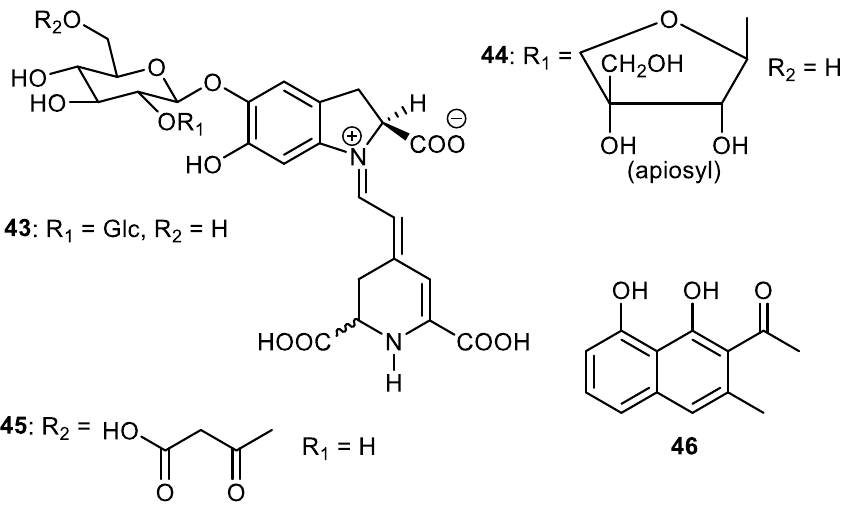
Figure 6. Structures of naphthalene and betacyanins 43 – 46 .